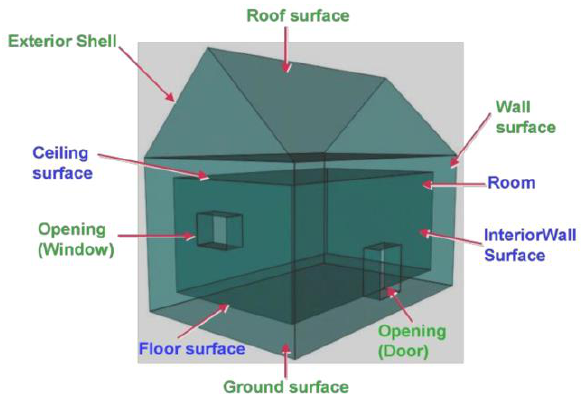
Figure 2. Thematic decomposition of a building in